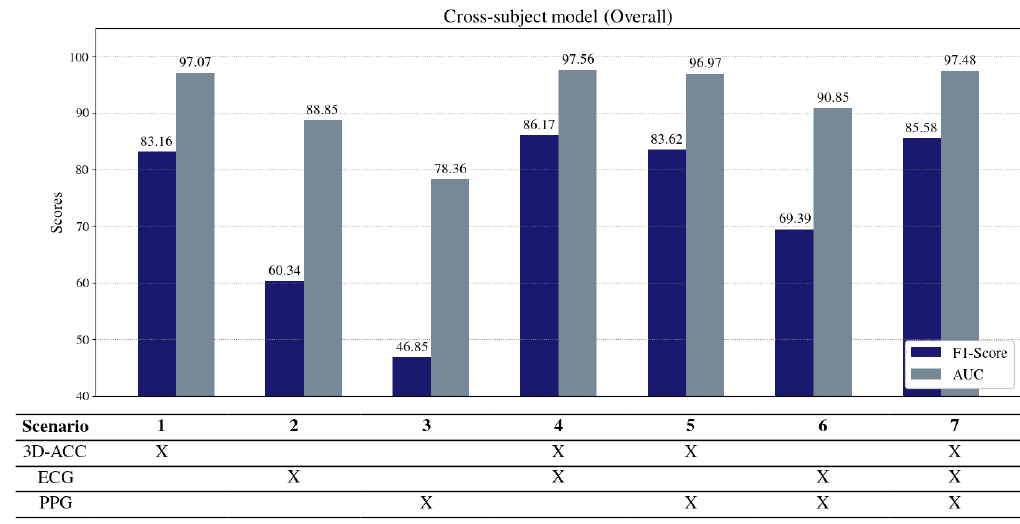
Figure 7. Cross-subject model results.